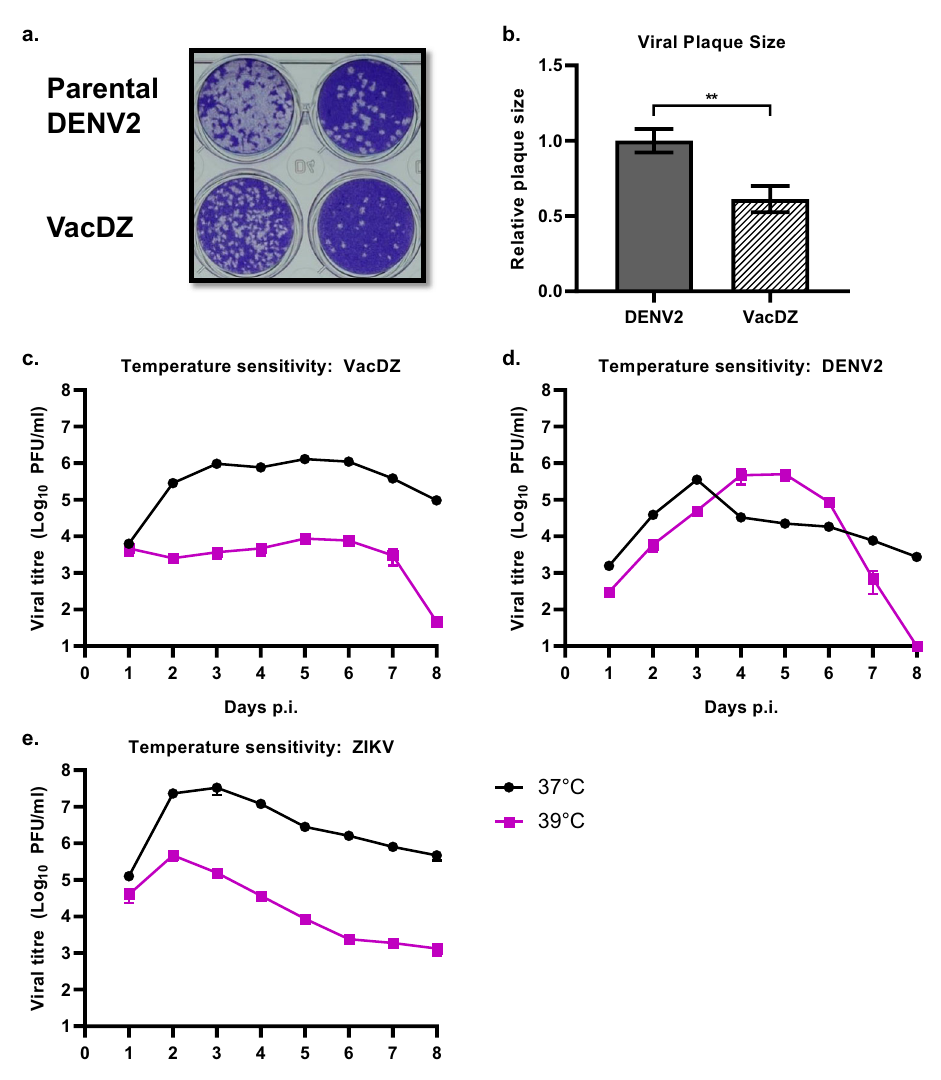
Fig. 2 Plaque formation and temperature sensitivity assay. VacDZ was investigated for markers of attenuation in cell culture. a Plaque formation assay in BHK-21 cells for VacDZ and parental DENV2-16681 to investigate small plaque phenotype. Incubation time for both viruses was six days. Plaques were then visualized by crystal violet staining. b Comparison of mean plaque sizes for VacDZ and parental DENV2-16681, measured by pixel width. Data represents mean of 10 plaques. Statistical analysis was performed using one way ANOVA. Statistical signi fi cance: *, P < 0.05; **, P < 0.01; ***, P < 0.001. Temperature sensitivity assay for c VacDZ, d DENV2-16681, and e ZIKV was performed by comparing the viral replication kinetics in BHK-21 cells at 37 °C and 39 °C (black and magenta lines respectively). Viral replication titres were analysed using plaque assay. Temperature sensitivity is de fi ned as a reduction in viral titre (PFU/ml) of 1-log or more at 39 °C relative to 37 °C. Data represents the mean of three